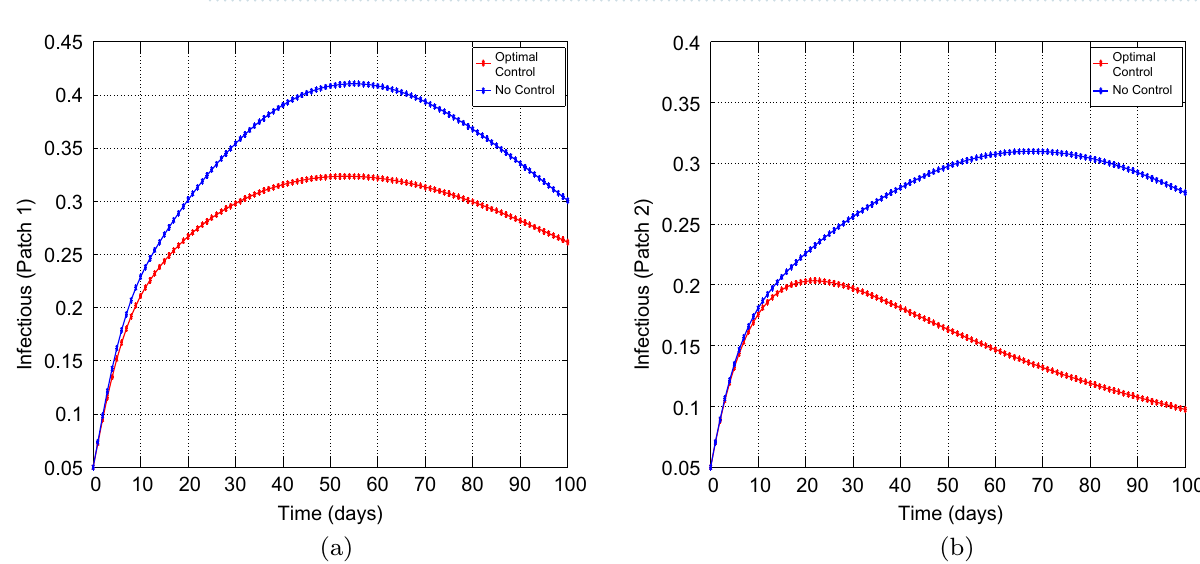
Figure 2. Simulation outcomes for the presented two patch COVID-19 mathematical model for case 1 under symmetric weak coupling ( a ) the number of infected humans in patch 1 ( b ) the number of infected humans in patch 2. In both figures, the red curves and blue curves are for the infected population, with optimal control and no optimal control respectively.